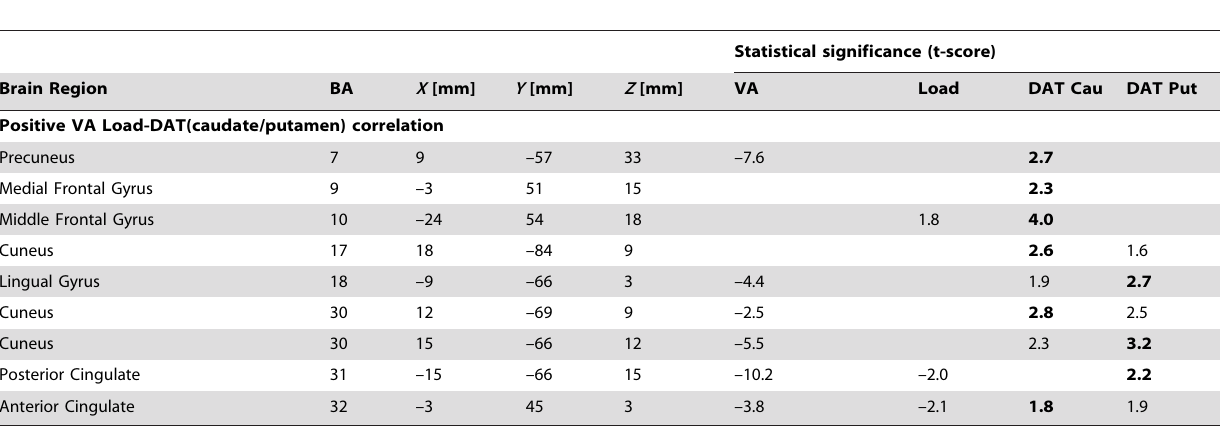
Table 5. Average statistical significance in regions-of-interest exhibiting correlations between VA-load signals and DA transporters in caudate/putamen.